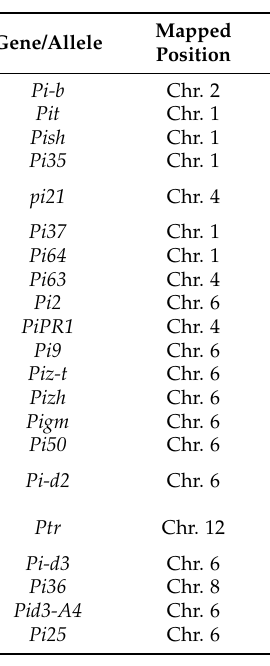
Table 1. Information about cloned rice blast resistance